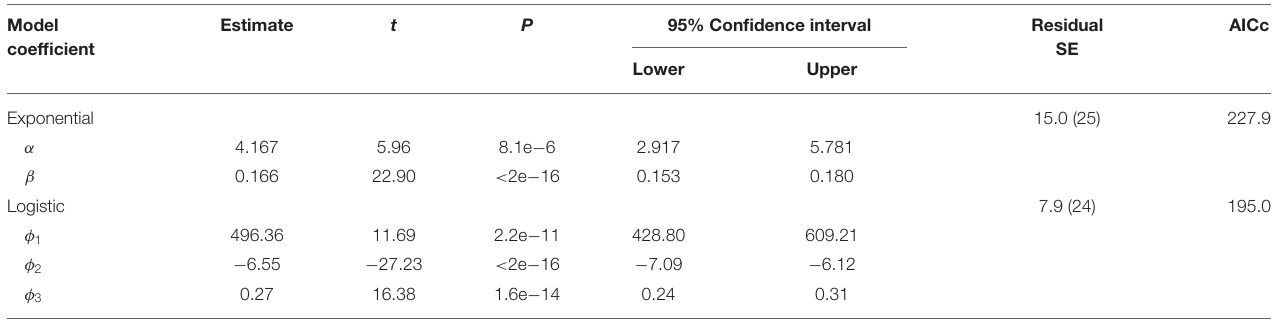
TABLE 2 | Exponential and logistic models fitted to camera-trap articles published annually from 1994 to 2020. Model